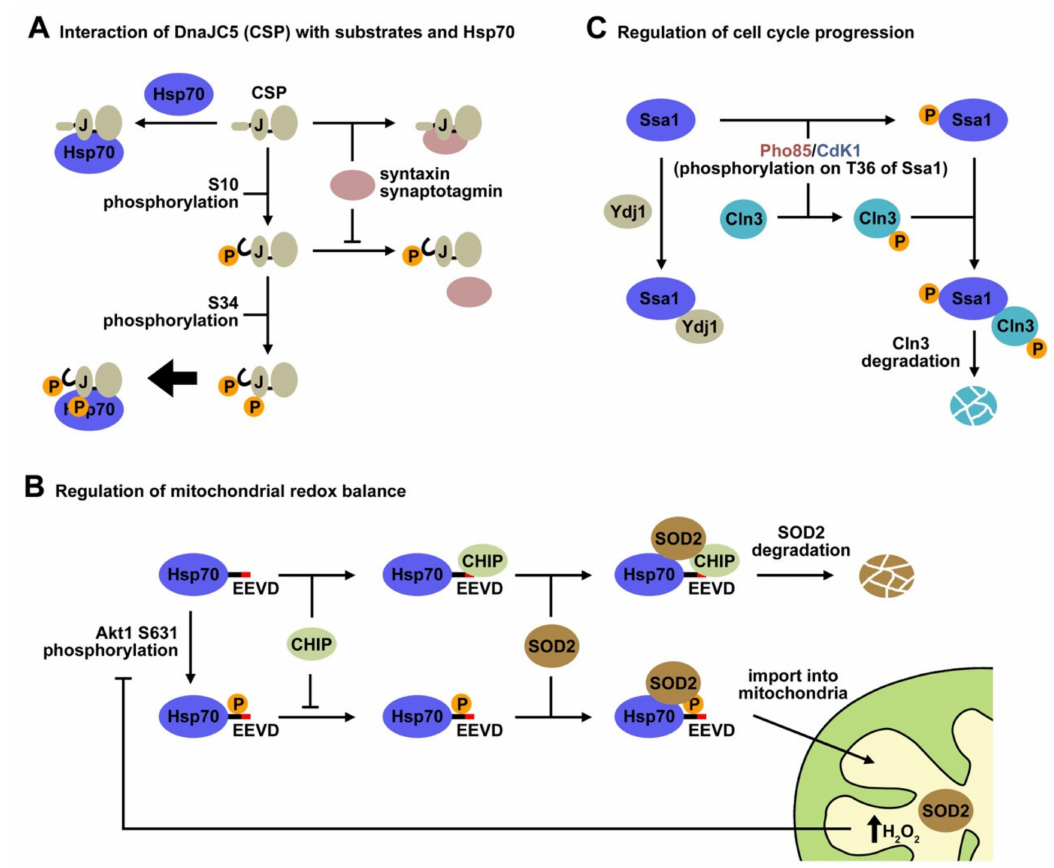
Figure 3. Phosphorylation of members of the Hsp40 and Hsp70 chaperone families regulates important physiological processes. ( A ) Phosphorylation of specific residues of CSP (DnaJC5) controls its interaction with di ff erent partners. Posphorylation at Ser10 induces an order-to-disorder transition in the N-terminal domain of CPS that weakens its interaction with syntaxin and synaptotagmin, but does not alter its bindig to Hsp70 [87]. However, double phosphorylation at Ser10 and Ser43 favors its interaction with Hsp70, resulting in a better chaperone activity that supports neuronal cell survival [88]. ( B ) Reversible phosphorylation of Hsp70 at Ser631 plays a key role in the regulation of mitochondrial redox balance. Hsp70 assists SOD2 in its e ffi cient translocation to the mitochondria and also drives SOD2 to degradation in complex with CHIP. Phosphorylation on Ser631 inhibits Hsp70-CHIP complex formation, thus promoting translocation of SOD2 into the mitochondria. The antioxidant activity of SOD2 increases the concentration of H 2 O 2 within the mitochondria, inducing expression of a phosphatase that deactivates Akt1, the kinase that phosphorylates Hsp70. This results in a lower Hsp70 phosphorylation rate, favoring CHIP binding to Hsp70 and SOD2 degradation [90]. ( C ) Yeast Hsp70 (Ssa1) modulates the cell cycle via its phosphorylation on Thr34, which occurs under nutrient limiting conditions or during the G2 / M phase. Phosphorylation of Ssa1 on Thr34 softens its interaction with Ydj1 and promotes chaperone binding to phosphorylated Cln3, which leads to Cln3 degradation and to the next G1 phase